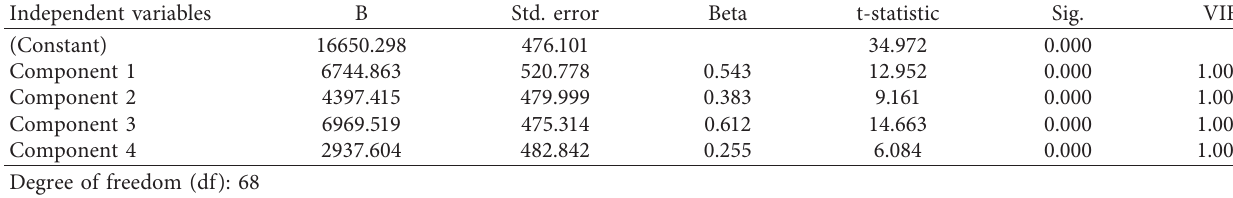
Table 6: Results of the PCR. Dependent variable: Ridership a